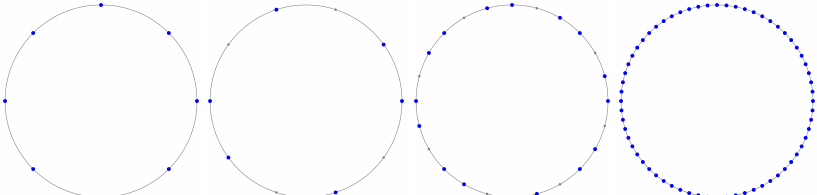
Figure 12. Examples of fiber position diagrams for the cases (left-to-right) of p = 4, 5, 12, 32. The blue dots are the positions of the fibers on the base space and the grey dots represent equal divisions of the circle in units of π / p . For example the bottom panel of Figure 8 corresponds to the first diagram. The unit cell size is (left-to-right) 1/8, 1/2, 1/8, 1/64. The saturation value is (left-to-right) 1, 3/5, 2/3,